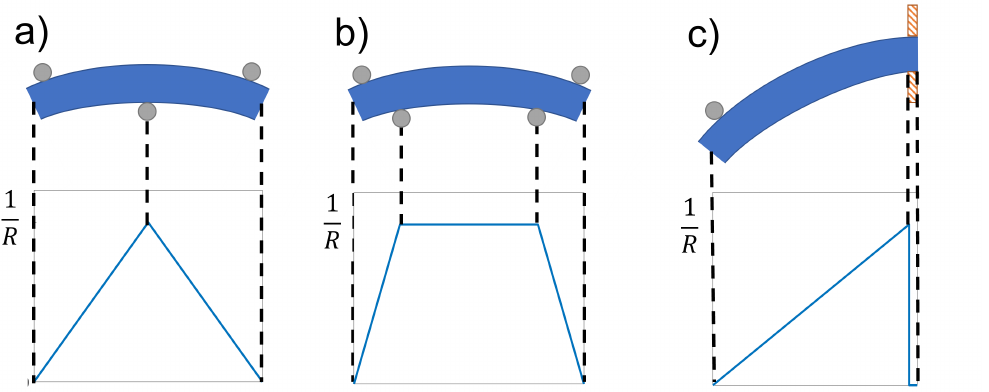
Figure 10. Several types of point bender. A crystal slate is bent by using cylindrical pins as fulcrums. The plot under each case indicate the curvature behaviour along the sample length expressed as 1/ R (where R is the radius of curvature). A perfectly uniform bending radius cannot be achieved along the entire length of the crystal [18].